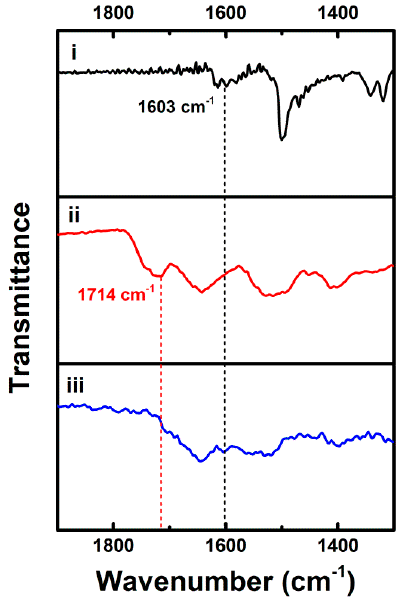
Figure 3. FT-IR spectra of (i) free dopamine, (ii) as-synthesized Au NCs, and (iii) dopamine-conjugated Au NCs in the 1300–1900 cm − 1 region.